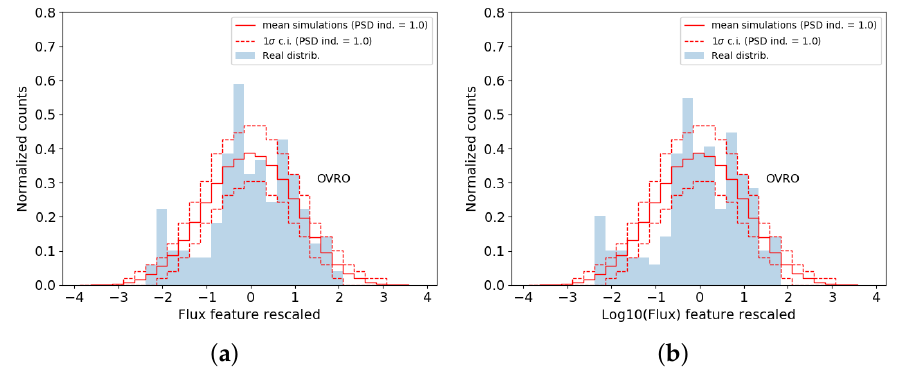
Figure 3. Similar to Figure 1 for OVRO lightcurves. Between ( a ) normal simulations and ( b ) lognormal ones, the normal distribution is a somewhat better fit with SW p -values of 2.31 × 10 − 4 relative to 4.80 × 10 − 6 . Once again the multi-modal, bursty structure makes it complex to explain with a single model for